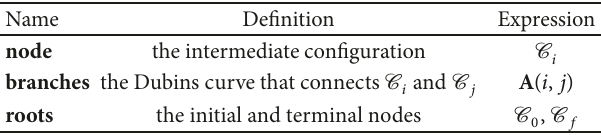
Figure 2: Outline of the Dubins tree. In this figure, the Dubins tree has 2 roots, 6 nodes, and 10 branches. Table 2: Dubins tree symbol